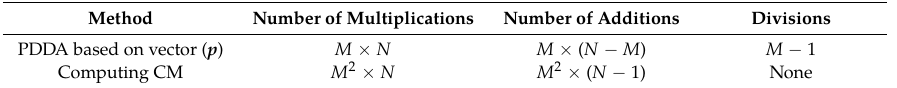
Table1. Computational operations required to construct the CM compared with the p vector construction . Method Number of Multiplications Number of Additions